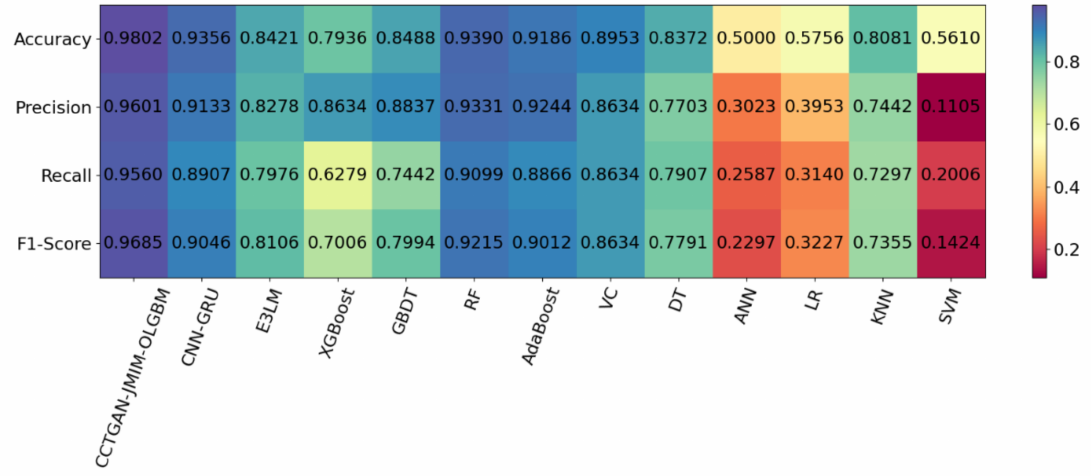
Figure 16. Performance comparison of different FDIA detection